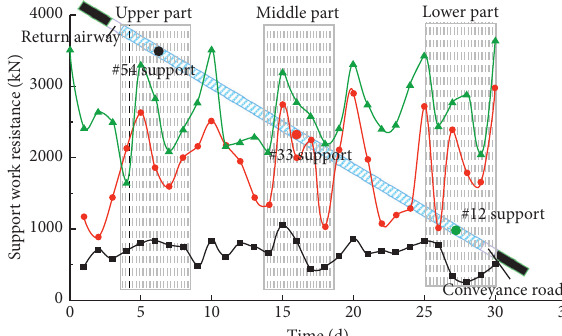
Figure 4: The support work resistance in different parts of the 12124 working